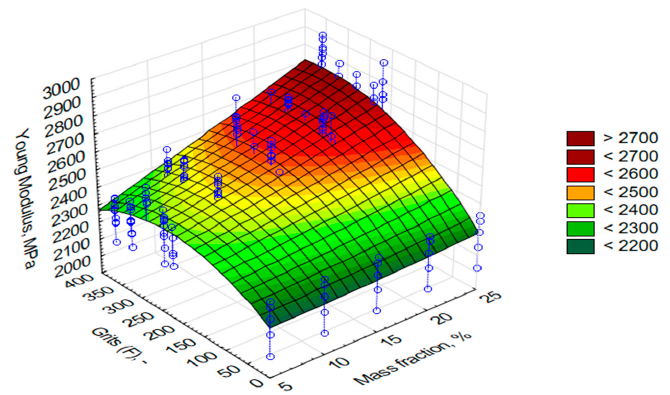
Figure 6. Graph of the modulus of elasticity values of the material for samples made with L285 resin and H285 hardener with an addition of alundum with the following grains: F220, F240, F280, F320, and F360, with various percentage mass shares.